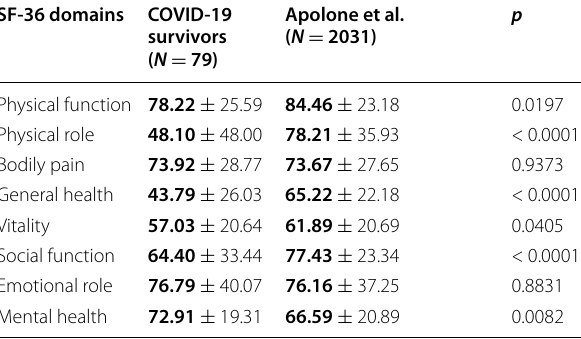
Table 2 SF-36 domain scores of C-ARDS survivors compared to Italian normalized data